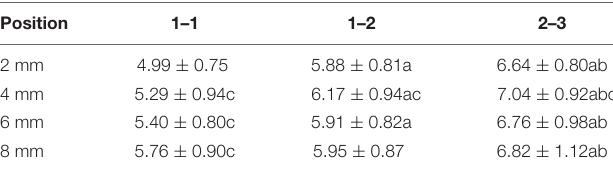
TABLE 3 | CBCT results of the buccolingual dimension in the mandibular anterior tooth region (mm, ¯ x ±